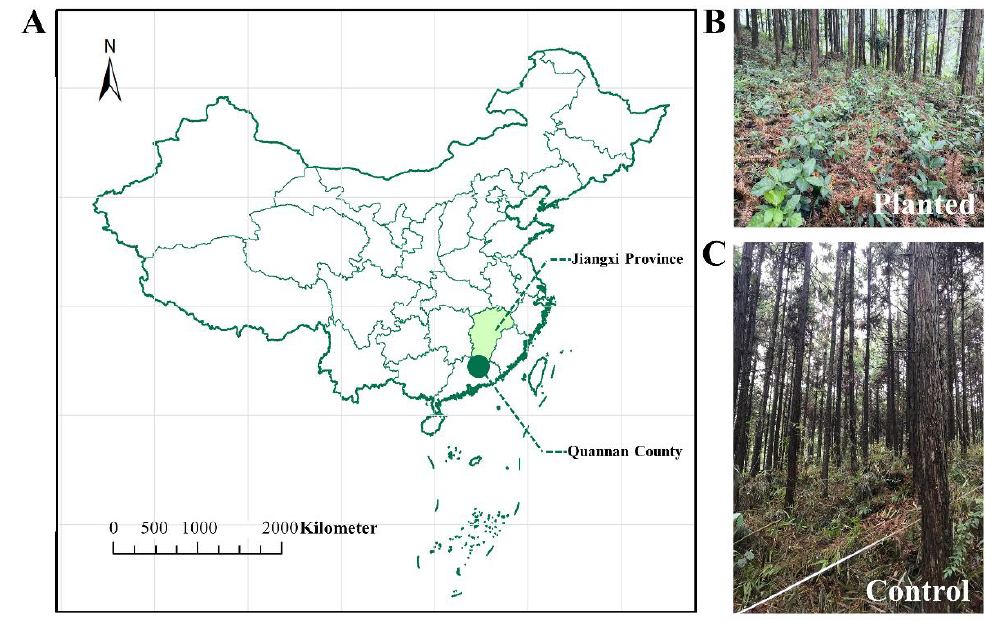
Figure 1. The sampling site. ( A ) depicts the detailed location of the site, and ( B , C ) depict the vege- tations of the planted and control groups,